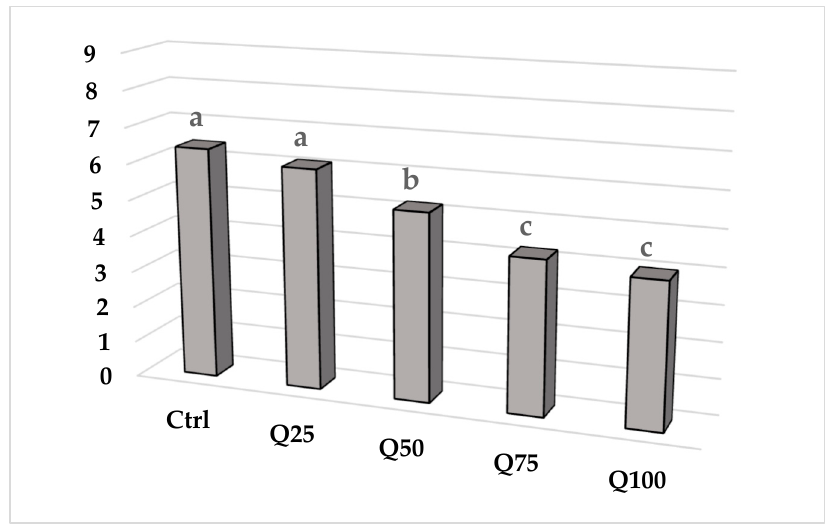
Figure 2. Influence of different substitution rates of QF on the ANOVA results of overall liking mean scores ( p < 0.05) of GF ladyfinger biscuits. Values with the same letter do not differ significantly from each other according to LSD test ( p < 0.05).